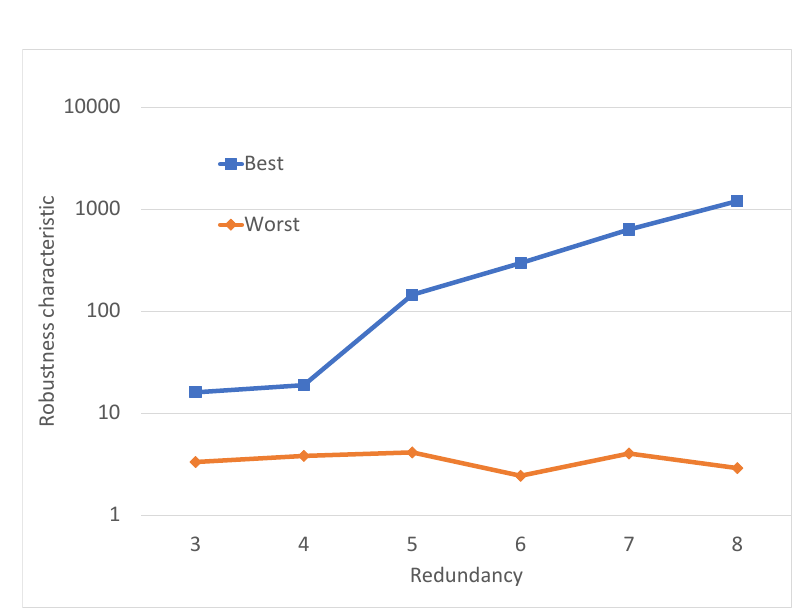
Figure 1: Best and worst robustness characteristics without re-randomization as a function of